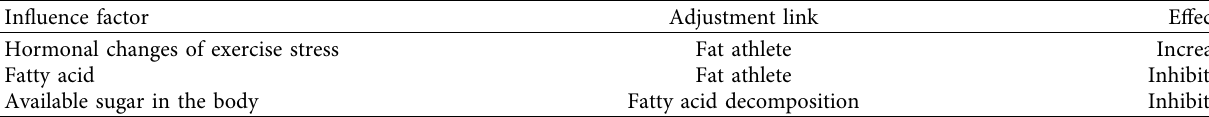
Table 1: Influencing factors of fat energy supply during